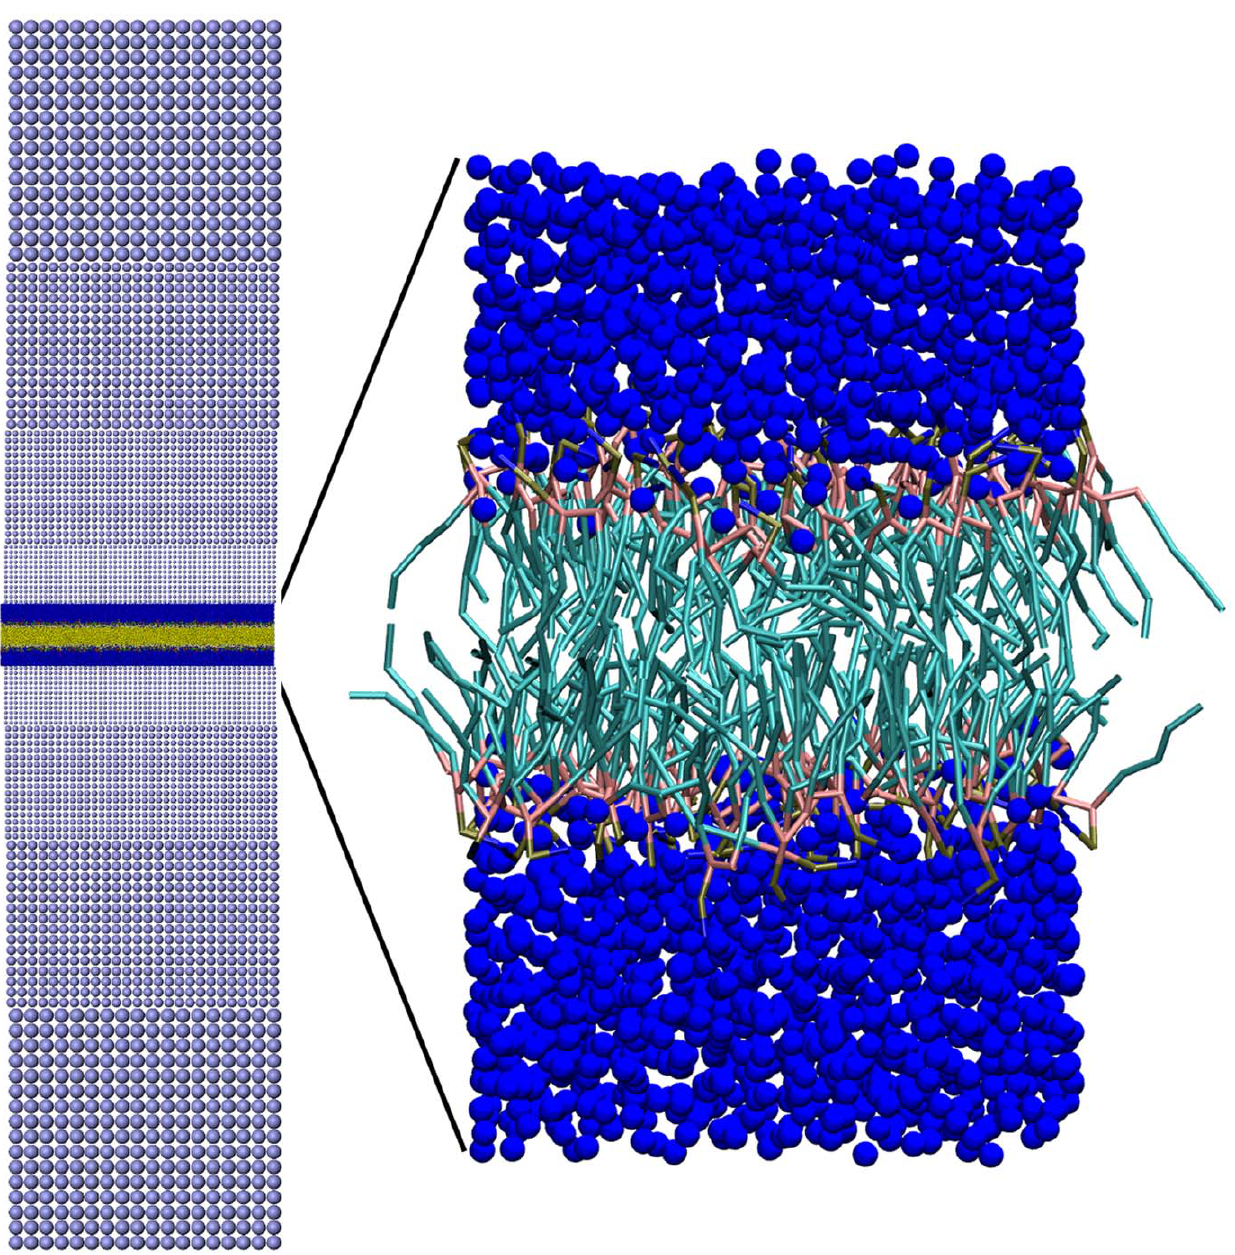
Figure 7. Multi-scale simulation setup. The left part shows the entire simulation domain with dimensions 447 | 447 | 1990A 3 . Starting from top and bottom, the continuum domain is represented by SPH particles (light blue) which decrease in mass towards the center of the simulation domain. At the center, a coarse grained MD domain is located. Herein, a phospholipid bilayer (yellow, red, and green) is solvated in water (dark blue). The right part of this figure zooms in on the MD domain, showing blue water and the structure of the bilayer, with hydrophilic lipid head groups (red) and hydrophobic lipid tails (cyan). The simulation domain contains 173264 MD and 150808 SPH particles. Periodic boundary conditions are applied along x and y , but not along the z